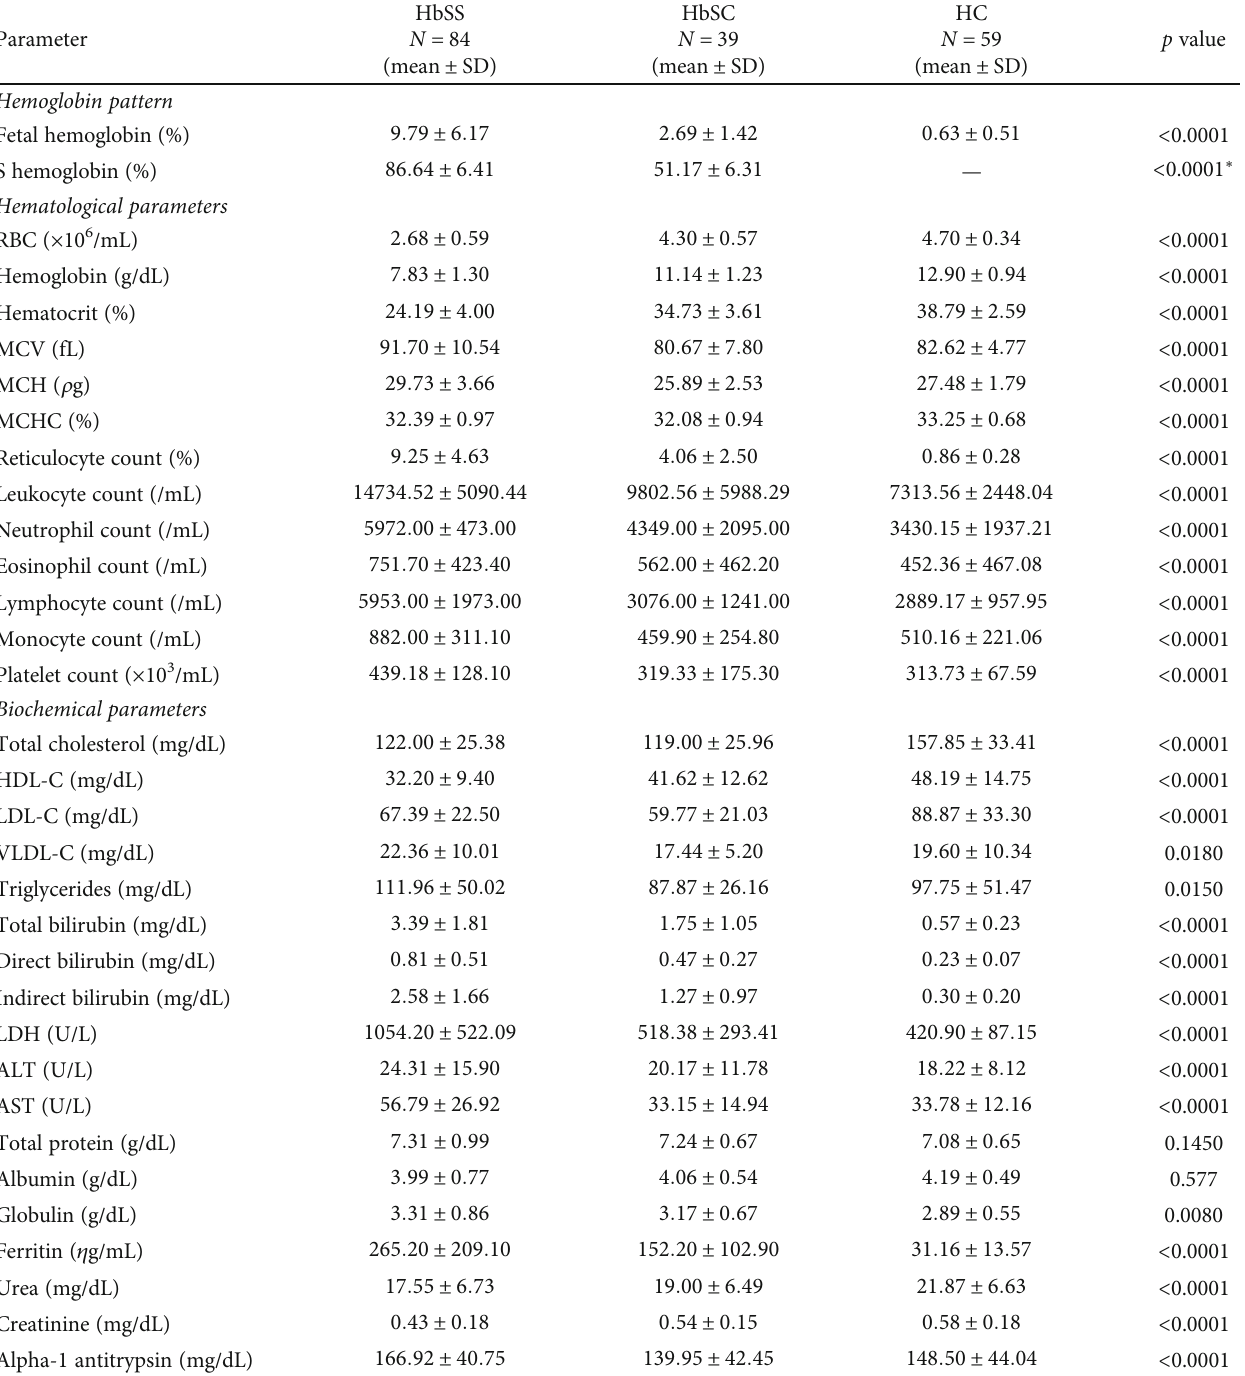
Table 1: Laboratory pro fi le of pediatric patients with sickle cell anemia (HbSS), hemoglobin SC disease (HbSC), and healthy controls (HC). Parameter